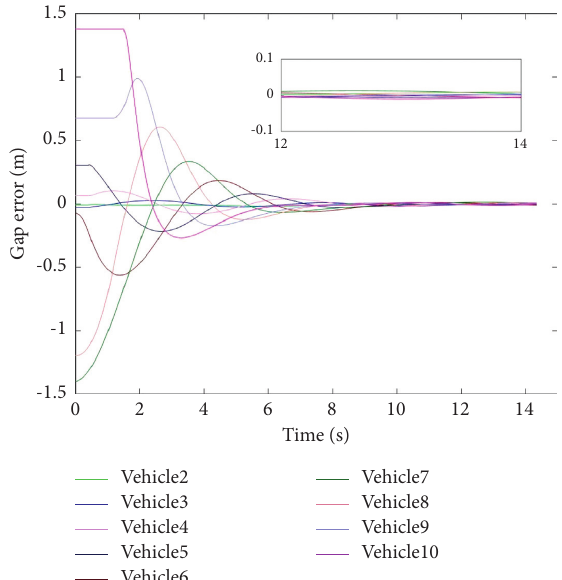
Figure 8: Gap error history under proposed controller